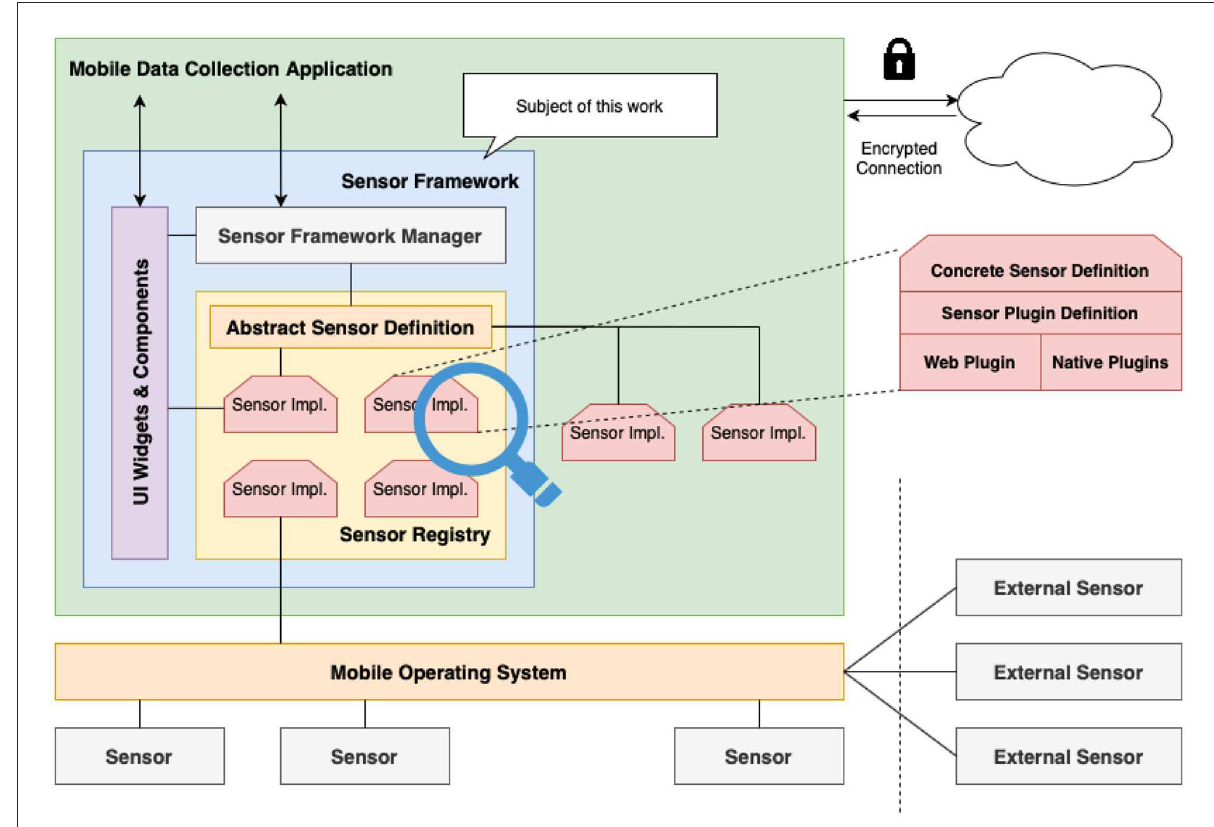
FIGURE1 Architecture of the sensor